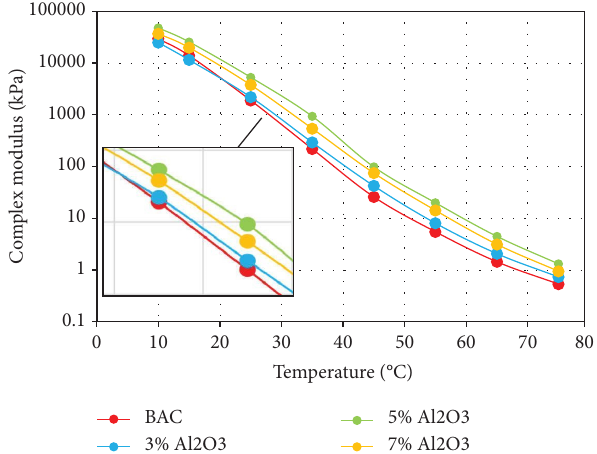
Figure 4: Isochronal plot for G ∗ of base and modifed asphalt binders.